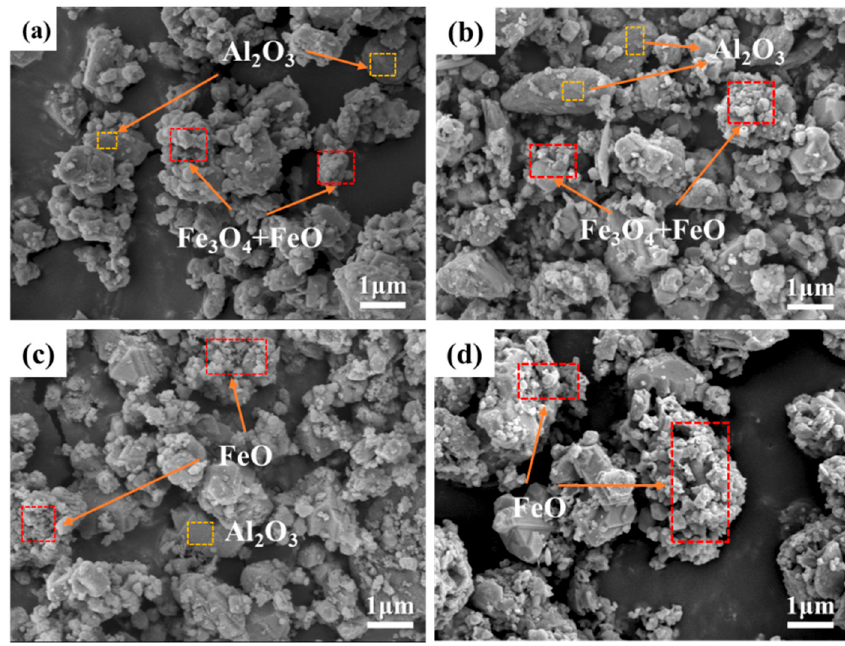
Figure 5. The SEM images of S 1 (mFe 2 O 3 /mAl 2 O 3 = 1:1) in ( a ), S 2 (mFe 2 O 3 /mAl 2 O 3 = 3:2) in ( b ), S 3 (mFe 2 O 3 /mAl 2 O 3 = 2:1) in ( c ), and S 4 (mFe 2 O 3 /mAl 2 O 3 = 4:1) in ( d ) at 2.3V, 850 °C, and 4 h.